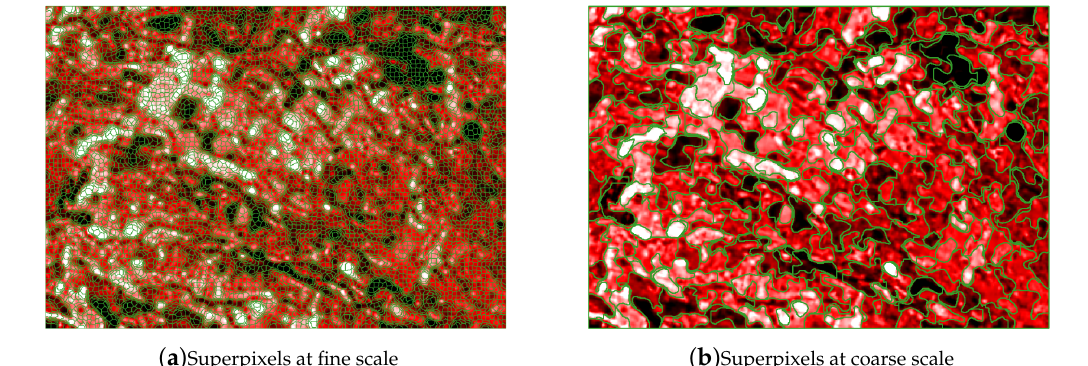
Figure 4. Segment obtained by SP strategy at: ( a ) fine scale ( k = 5) and ( b ) coarse scale ( k = 8) for the TIR 1